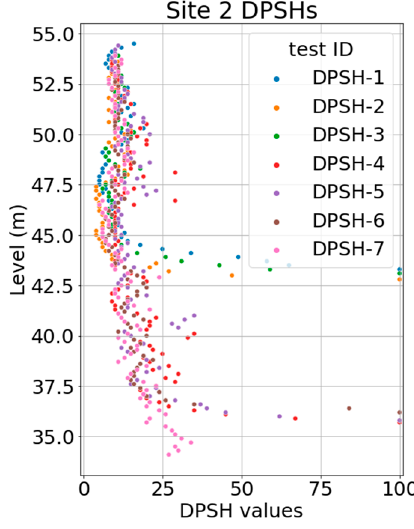
Figure 5. DPSH values for site 2.